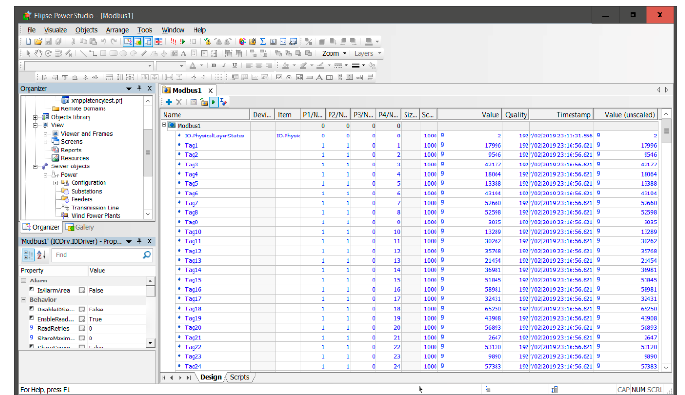
Figure 13. Modbus master in Elipse Studio.